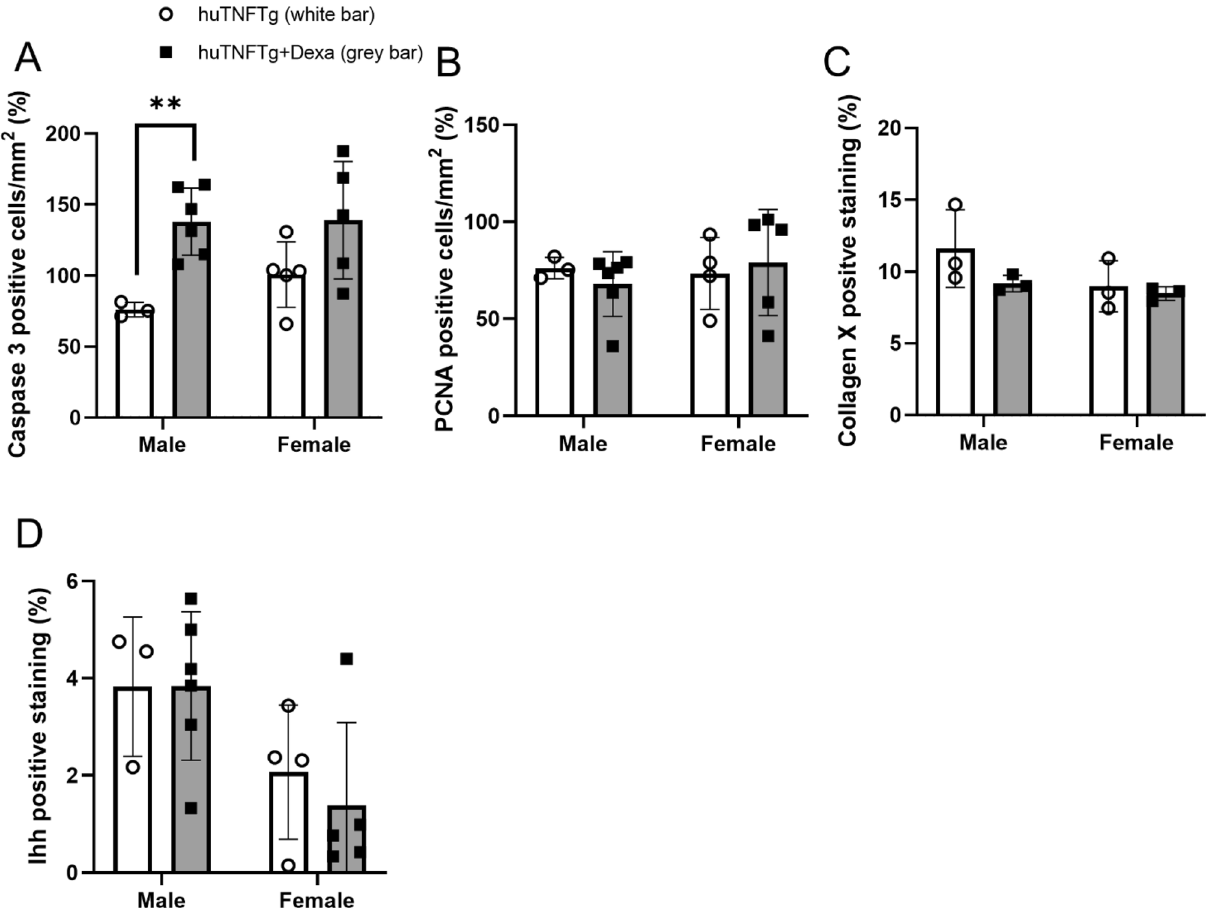
Figure 7. Effects of Dexamethasone (Dexa) treatment on chondrocyte proliferation, hypertrophy and apoptosis in huTNFTg mice (males and females analyzed separately). ( A ) Quantitative analysis of Ihh staining, ( B ) collagen type-X staining, expressed as number of positive cells per mm 2 , ( C ) PCNA staining, ( D ) and caspase-3 staining, expressed as percent of positively stained area over total growth plate area. (n = 3–6). ** p <